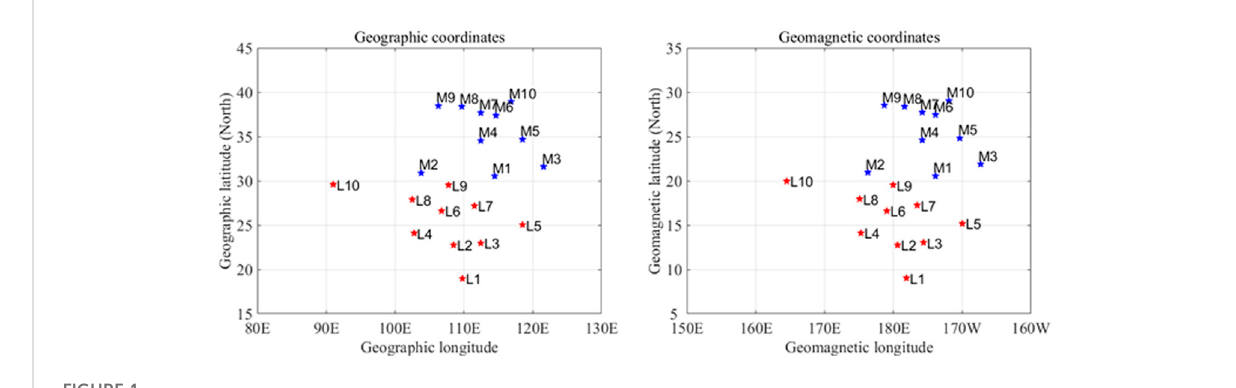
FIGURE 1 Positions of all 20 stations.